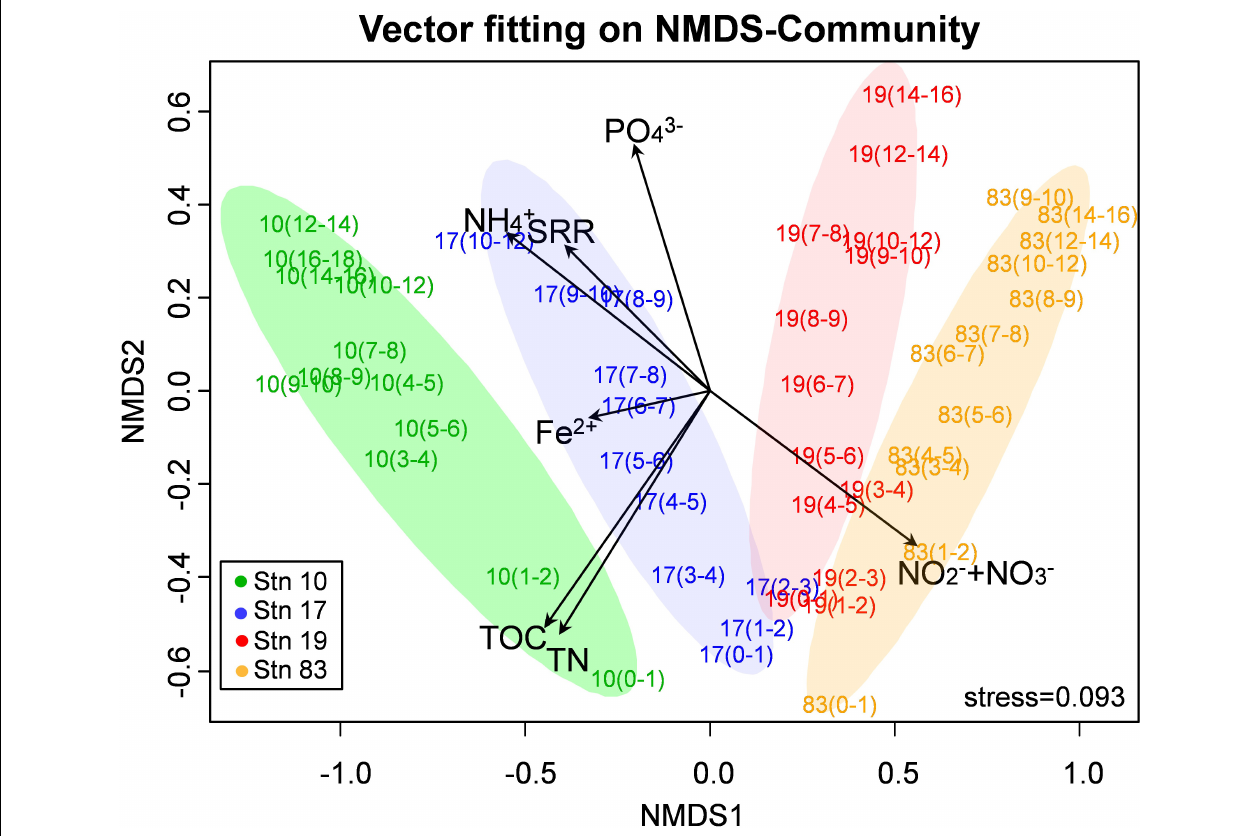
FIGURE 3 | Microbial community by 16S rRNA gene (non-metric multidimensional scaling ordination) showing the microbial communities segregated according to the polynya and non-polynya, driven by differences in nutrients (NH + 4 , Fe 2 + , and PO 3 − 4 ), contents of total organic carbon (TOC) and total nitrogen (TN), and sulfate reduction rate